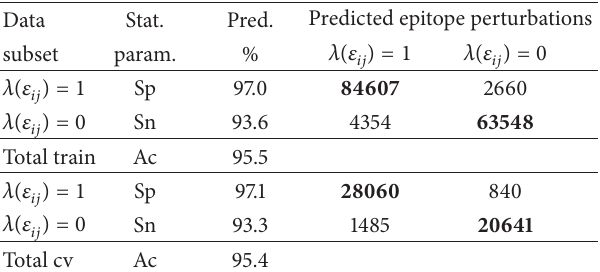
Table 1: Results of QSPR-perturbation model for IEDB